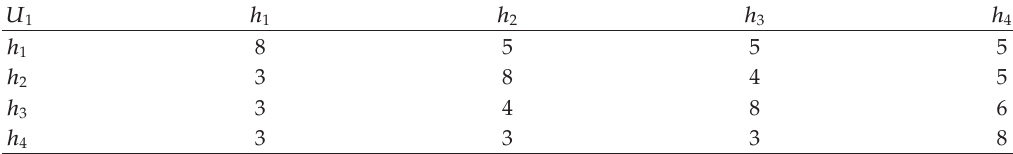
(cid:5) H,D (cid:6) .